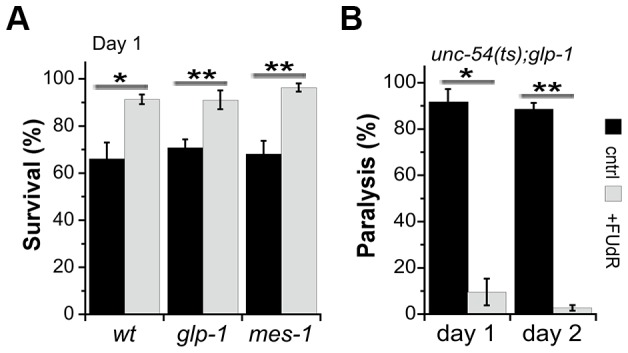
FUdR effects on proteostasis during development are independent of GSC inhibition.(A) Age-synchronized glp-1(e2141) animals raised in the absence (black) or presence (gray) of FUdR were exposed to a 37°C HS for 6 h on the first day of adulthood and survival was assayed. Data represent means ± SEM of >5 independent experiments. P values compare age-matched treated and untreated animals. (*) P<0.05 and (**) P<0.01. (B) The motility of age-synchronized unc-54(e1301);glp-1(e2141) animals raised in the absence (black) or presence (gray) of FUdR was examined on the first and second days of adulthood and the percent of paralyzed animals was scored. Data represent means ± SEM of >3 independent experiments. P values compare age-matched treated and untreated animals. (*) P<0.05 and (**) P<0.01.